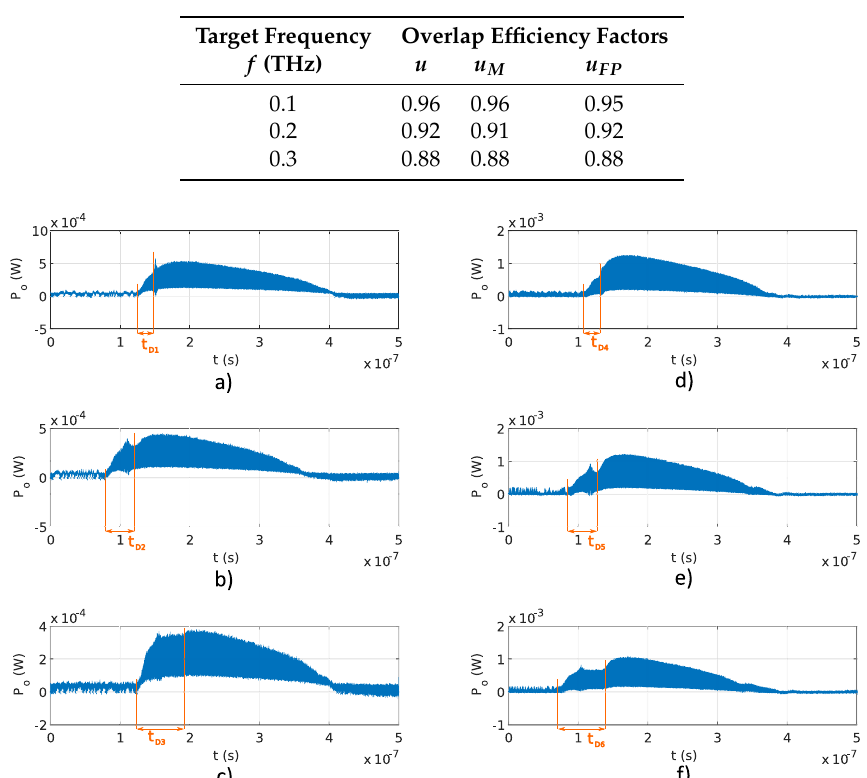
Figure 8. Pulses generated using Fabry–Perot and Michelson interferometer with OPD reported in Table 1: ( a ) Fabry–Perot interferometer, f = 0.1 THz, u 1 = 0.95; ( b ) Fabry–Perot interferometer, f = 0.2 THz, u = 0.92; ( c ) Fabry–Perot interferometer, f = 0.3 THz, u = 0.88; ( d )